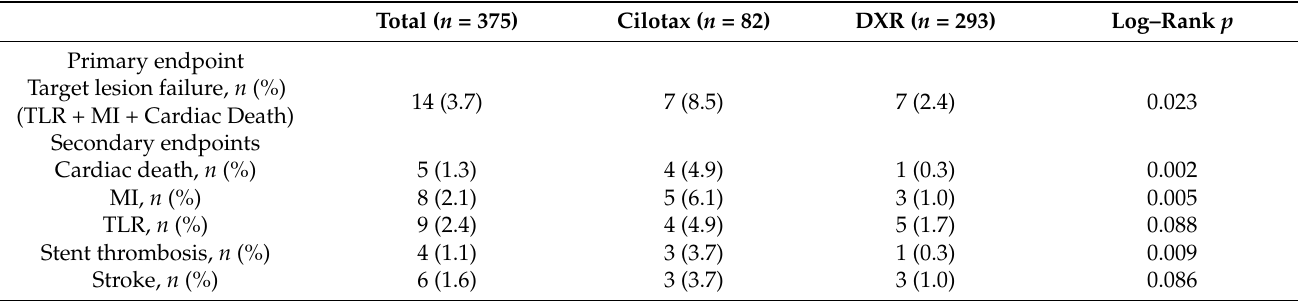
Table 3. 1-year clinical outcomes on stent type.